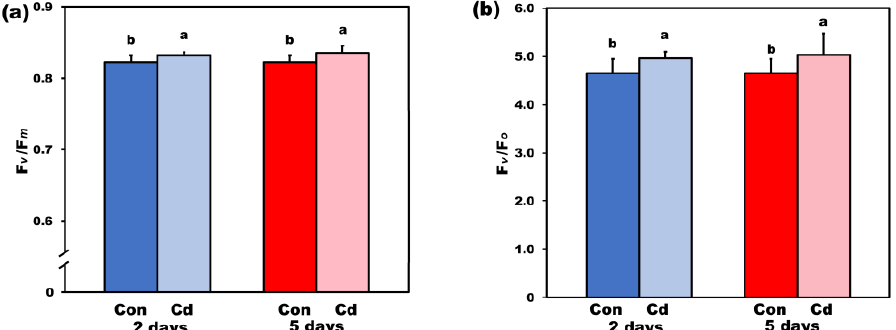
Figure 4 . The maximum efficiency of photosystem II (PSII) photochemistry (F v /F m ) ( a ), and the efficiency of the water-splitting complex on the donor side of PSII (F v /F o ) ( b ), of control (con) and 2- and 5-days Cd-treated Salvia sclarea plants. Error bars are standard deviations ( n = 6). Columns with different letters are statistically different ( p < 0.05).